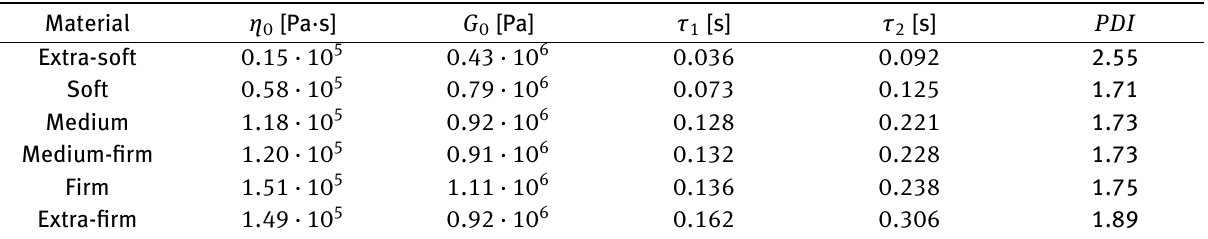
Table 2: Low-dimensional linear viscoelastic descriptions of the physical therapy putties, as calculated from the moments of the relaxation spectrum.